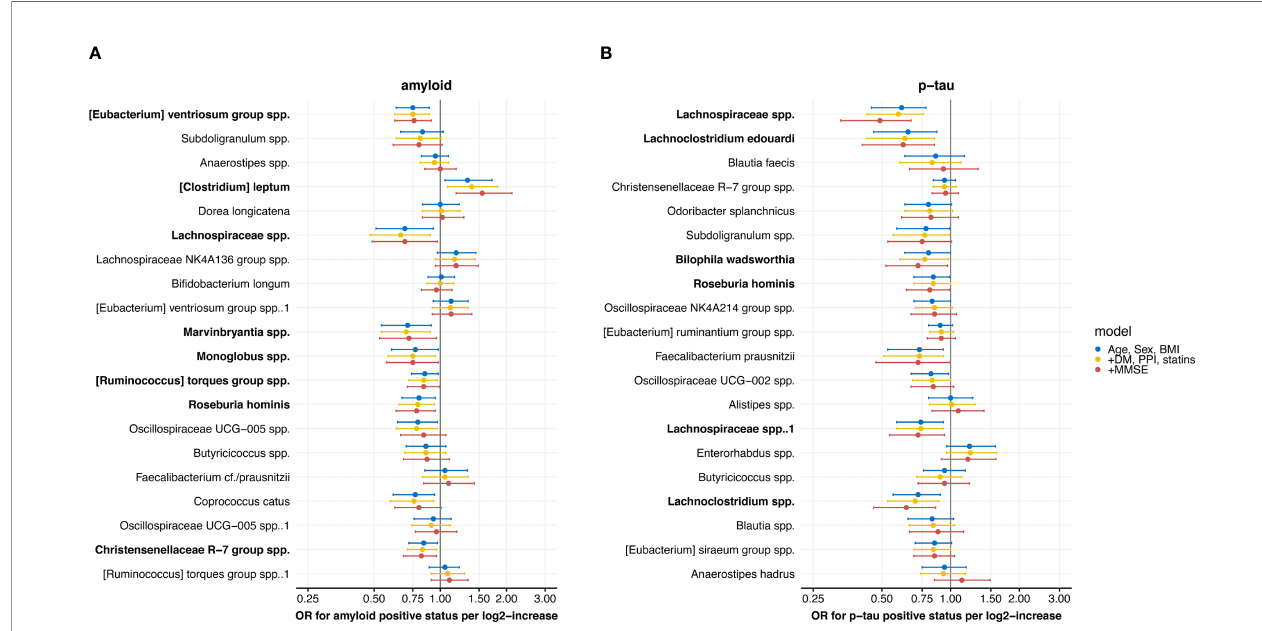
FIGURE 4 | Forest plots with results from the logistic regression models with associations between the 20 highest ranked microbial predictors from the machine learning model, ordered by ranking, and (A) amyloid and (B) p-tau positive status. Three models are shown: 1) adjusted for age, sex and body mass index (BMI), 2) additionally adjusted for diabetes mellitus (DM), use of proton pump inhibitors (PPI) and statins and 3) additionally adjusted for mini-mental state examination (MMSE) score. Results are presented as odds ratios (OR) with 95% con fi dence intervals. Microbes with signi fi cant associations in the fully adjusted model are marked in